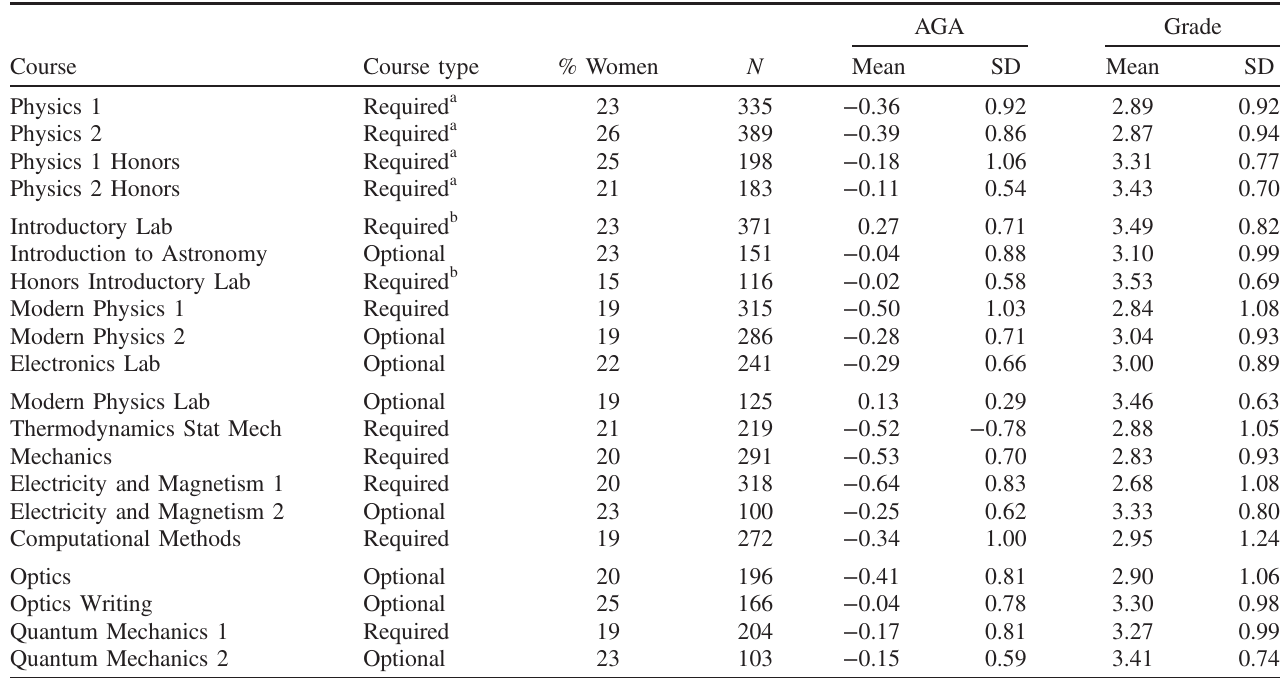
TABLE II. Mean and standard deviation (SD) of average grade anomalies and grades, number of students ( N ) for each course of interest, and the percentage of women that took the course. Courses are also marked as required or optional, which is accurate as of the final semester of data collection. Optional courses are typically chosen from a group of electives to fulfill degree requirements, though no specific course is mandatory. We used the following abbreviations: Laboratory (Lab) and Statistical Mechanics (Stat